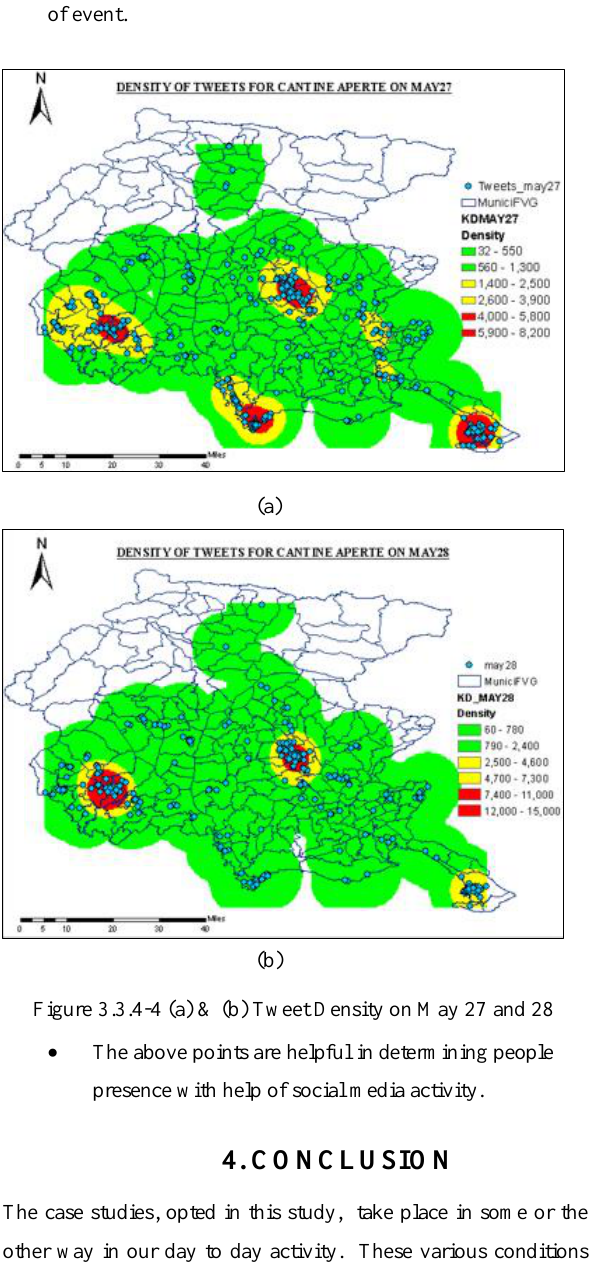
Figure 3.3.4-4 (a) & (b) Tweet Density on May 27 and 28